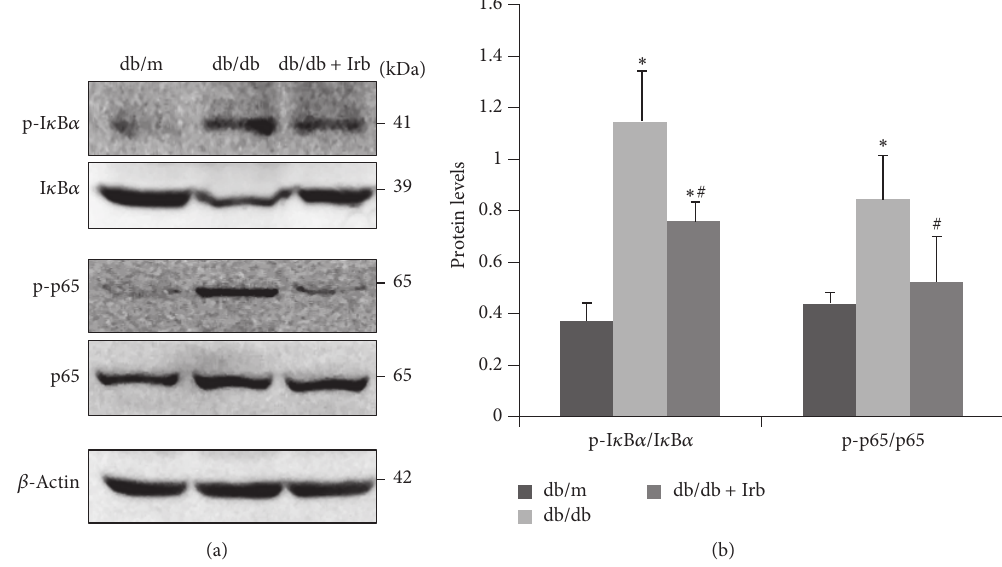
Figure 6: Irb inhibited NF- 𝜅 B pathway activation in db/db mice. (a) Representative immunoblot of p-I 𝜅 B 𝛼 , I 𝜅 B 𝛼 , p-p65, and p65 in the kidney. (b) Quantification of the immunoblot: the ratio between p-I 𝜅 B 𝛼 and I 𝜅 B 𝛼 and the ratio between p-p65 and p65 are presented. The bars in panel (b) show the mean expression in arbitrary units (error bars, SD). ∗ 𝑃 < 0.05 compared with db/m; # 𝑃 < 0.05 compared with db/db, 𝑡